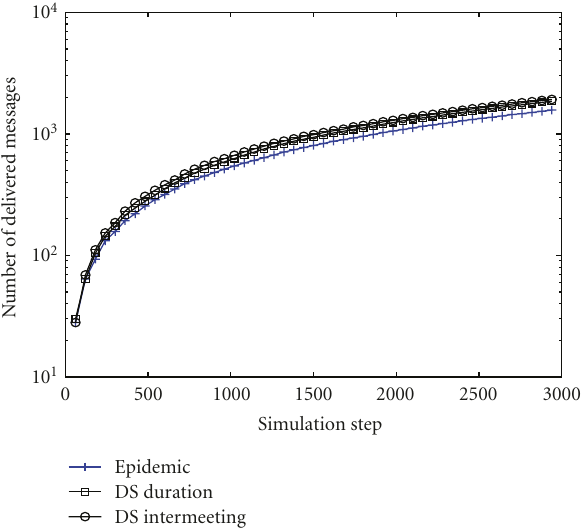
Figure 6: Number of forwarded messages under di ff erent routing